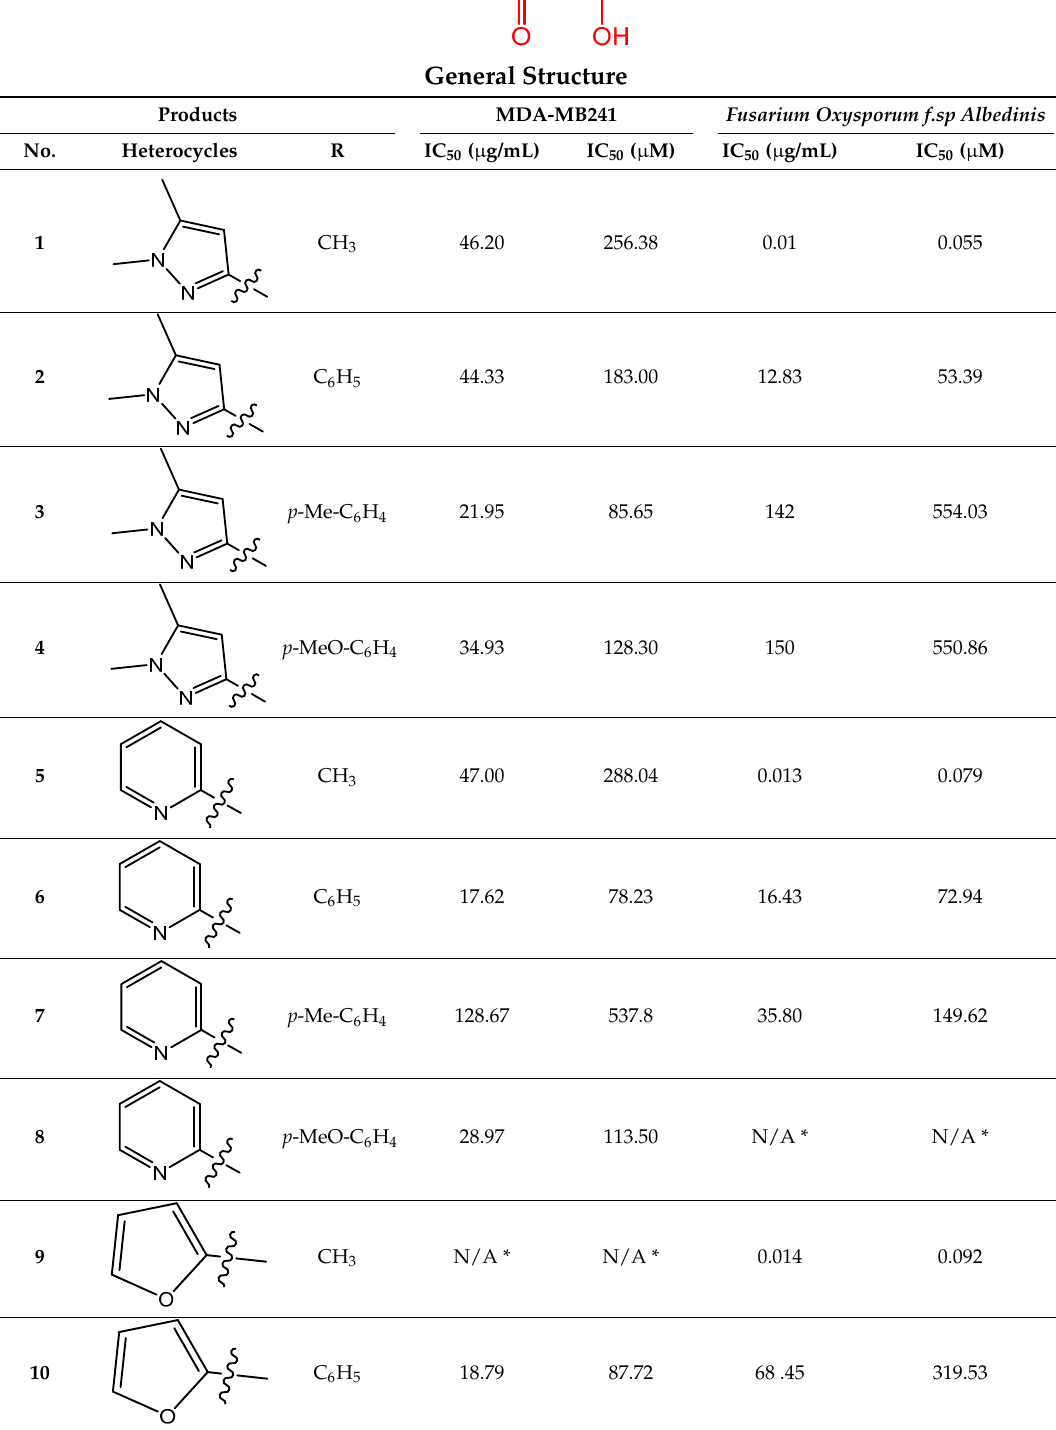
General Structure